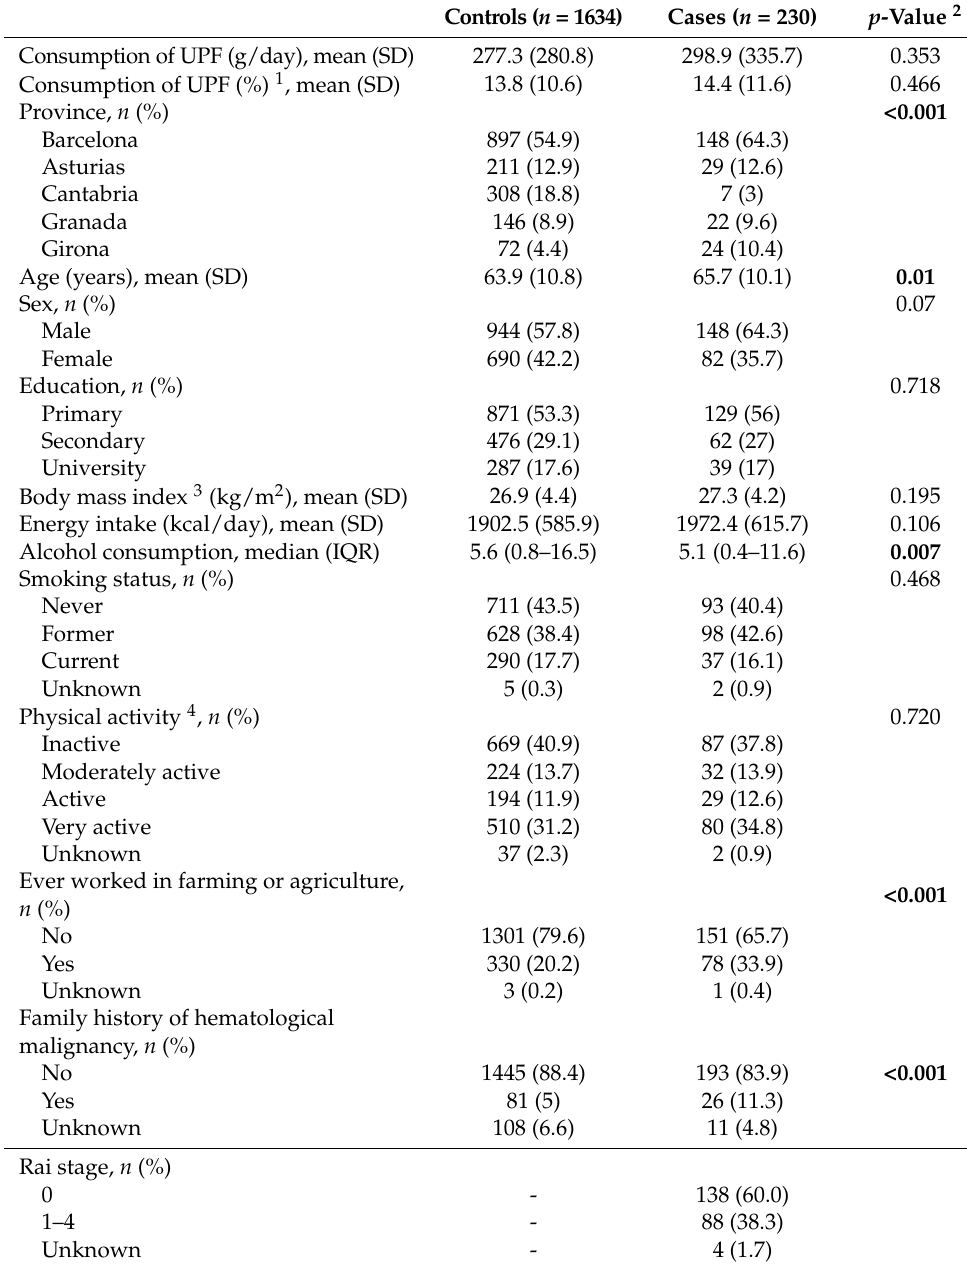
Table 1. Baseline characteristics of controls and cases in the MCC-Spain